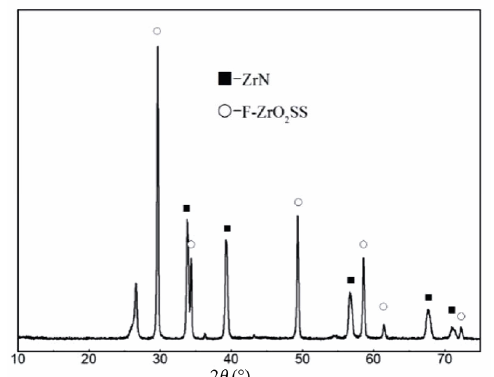
Fig. 8 Phase diagram of ZrN–ZrO 2 –Y 2 O 3 ternary system at 1750 ℃